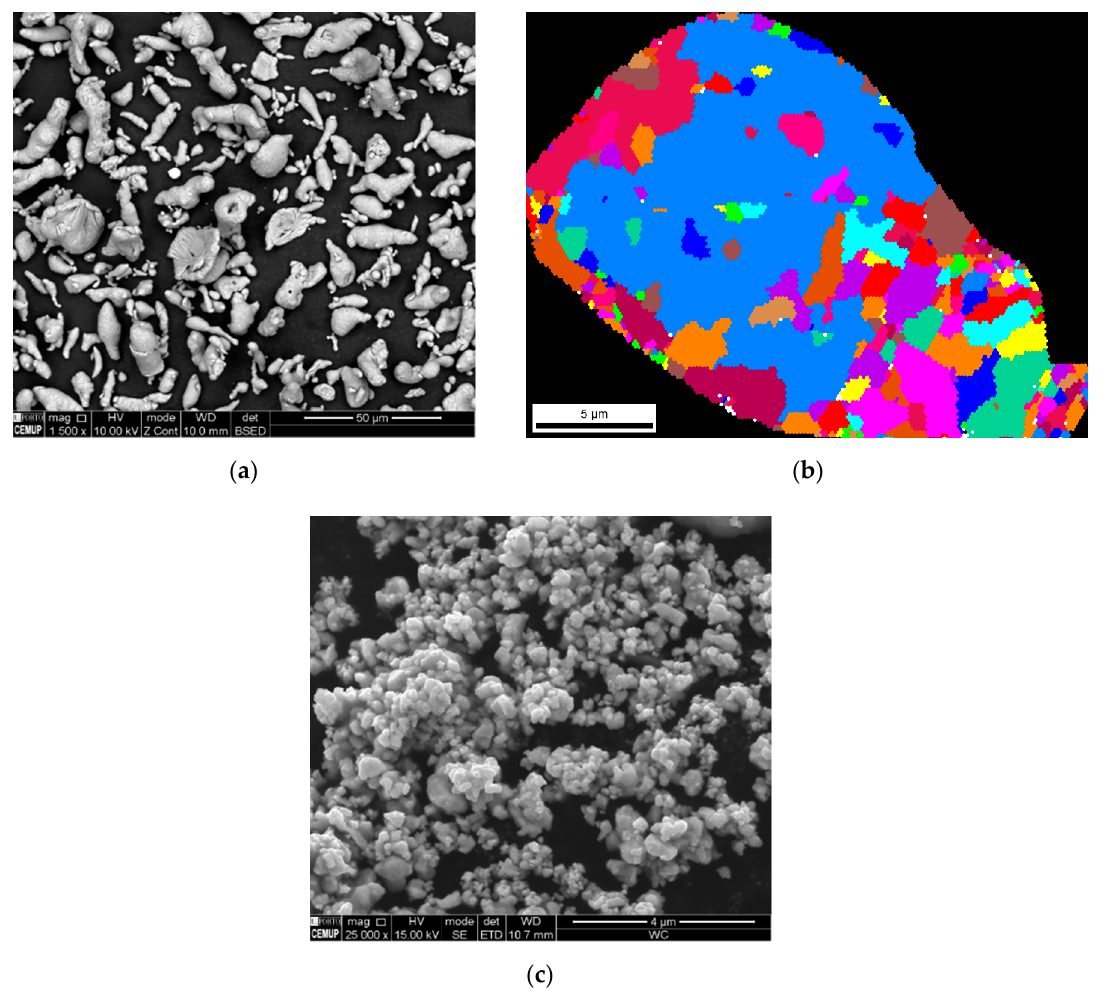
Figure 1. Microscopic characterization of input materials used in this study: ( a ) The morphology of Al powder (SEM/SE image), ( b ) EBSD grain colour map from an individual Al particle and ( c ) the tungsten carbide (WC) particles (SEM/SE image).